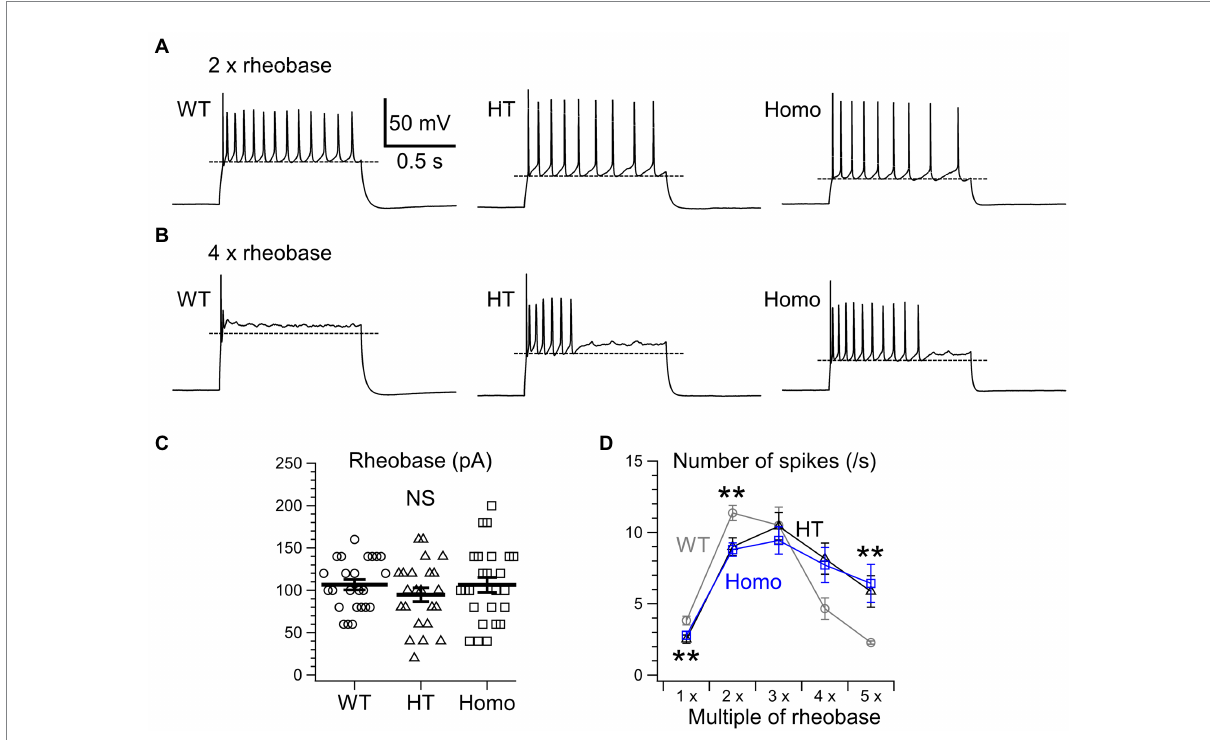
FIGURE 3 Repetitive AP firing induced by current injection for 1 s. (A) Representative traces of repetitive firing induced by injection of two times the rheobase current (2 × rheobase) in WT, HT, and Homo neurons. (B) The traces induced by 4 × rheobase in the same neurons as in (A) . Broken lines in (A,B) indicate mean minimum membrane voltage levels during interspike intervals in these examples. (C) Rheobase was determined by applying current steps in 20 pA increments. WT: 106.7 ± 6.1 pA, HT: 94.8 ± 8.2 pA, Homo: 106.4 ± 8.9 pA, p = 0.485 by ANOVA. Symbols indicate the values in individual neurons, and thick bars with error bars indicate means ± SEMs. NS, not significant. (D) The numbers of AP spikes induced by 1–5 × rheobase for 1 s in WT (gray), HT (black), and Homo (blue) neurons. Symbols with error bars indicate means ± SEMs. ** p < 0.01, WT vs. HT and Homo by